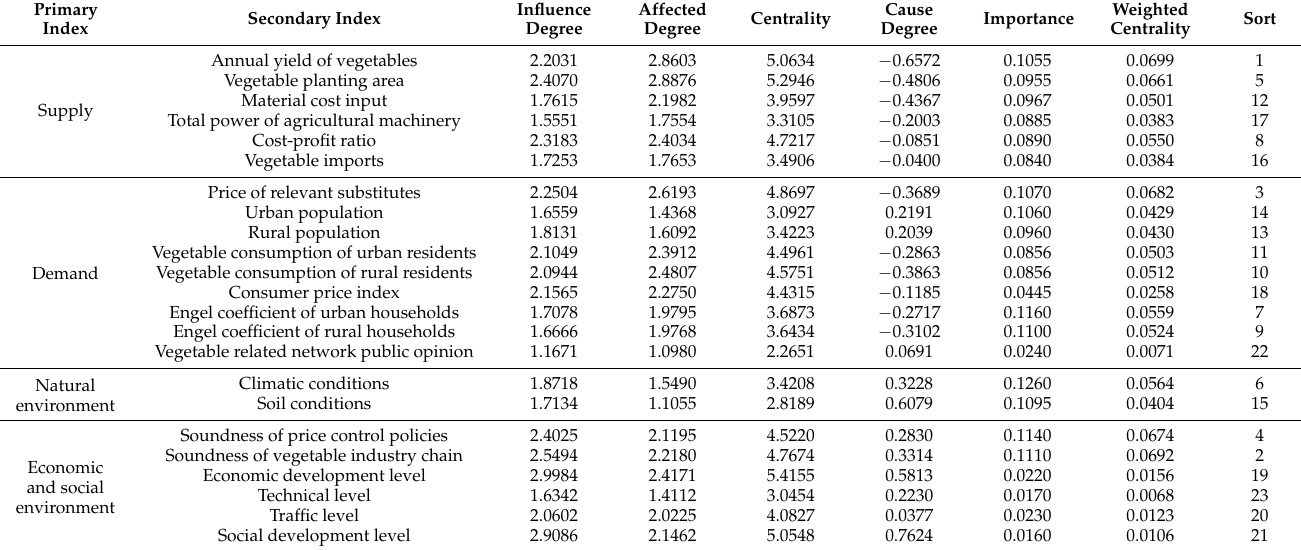
Table 7. Calculation results of improved concept lattice weighted group DEMATEL